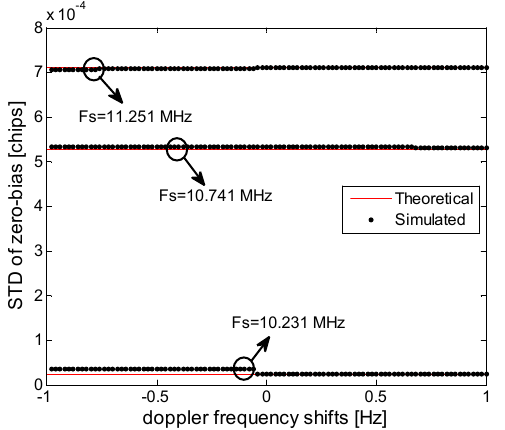
Figure 11. The zero-bias curve of the digital code phase discriminator of the BOCs (1, 1) signal with the code Doppler frequency ( F c = 1.023 MHz, 2 d c